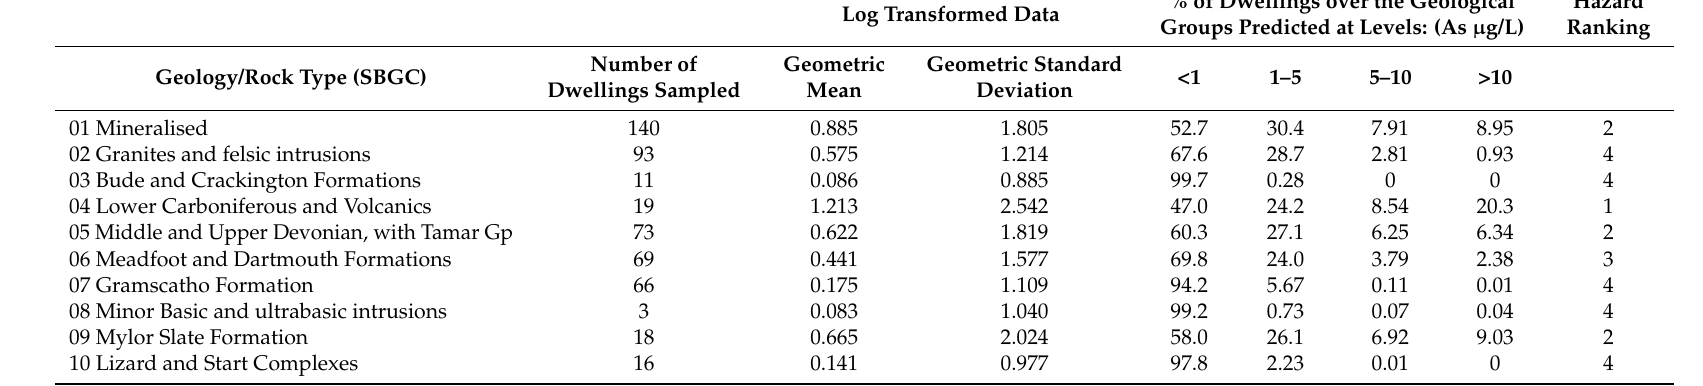
Table 2. Data transformations; summary statistics of logged transformed values, probability of dwellings being in an exposure category and hazard ranking of Simplified Bedrock Geological Classifications